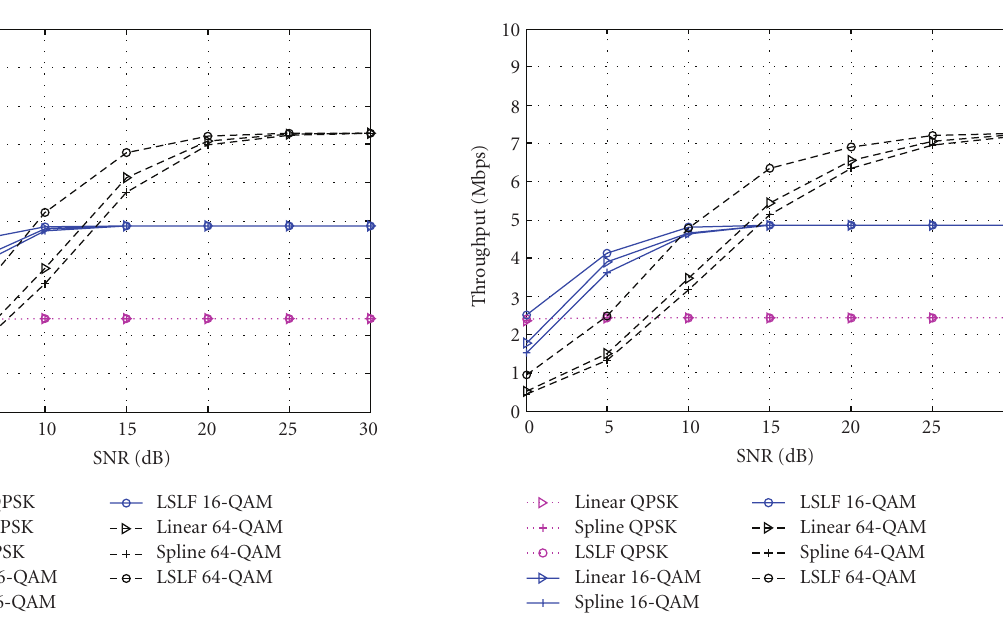
Figure 10: Throughput in Ped.B 6 km/h using channel tracking.